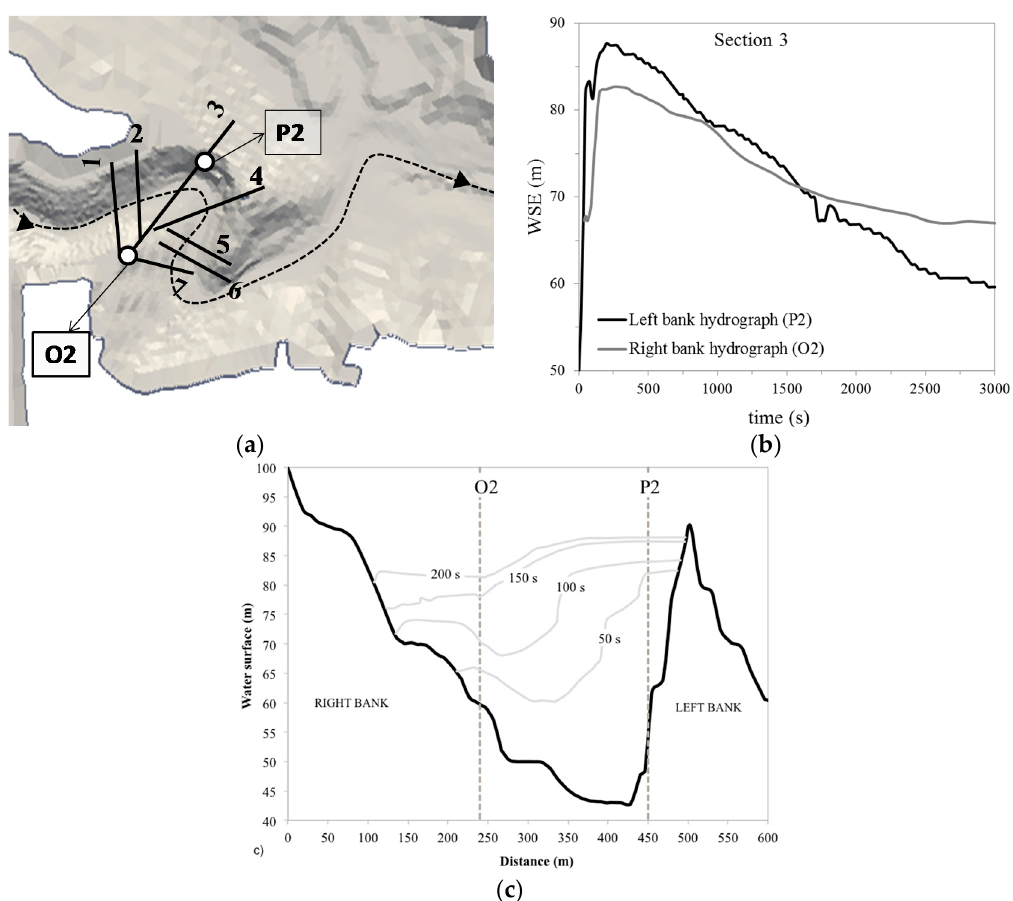
Figure 7. ( a ) Plan view of a Reyran River meander under investigation. Two points (i.e., P2 and O2) are considered on the opposite sides of the same river cross sections (i.e., Section 3); ( b ) The corresponding hydrographs in terms of water surface elevation (WSE) are shown: P2 (black line) and O2 (grey line); ( c ) Water surface elevation at different time steps: 50, 100, 150 and 200 s after the dam collapse.